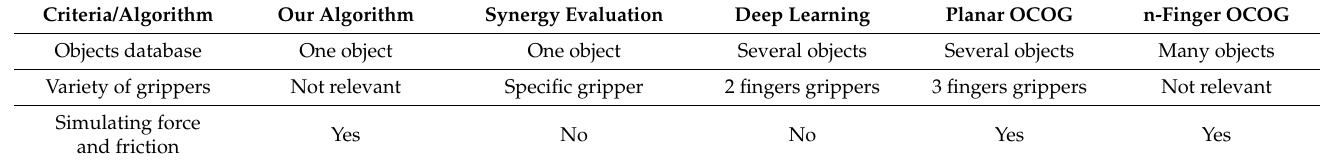
Table 7. Algorithm comparison to selected